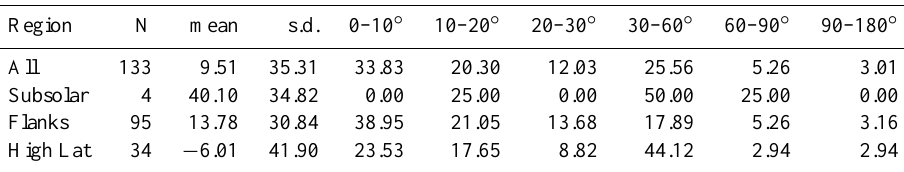
Table 12. Distribution of angular differences in the high pressure case (solar wind dynamic pressure > 2nPa) for Southward IMF (IMF clock angle between − 165 ◦ and 165 ◦ ). Format as in Table 3.